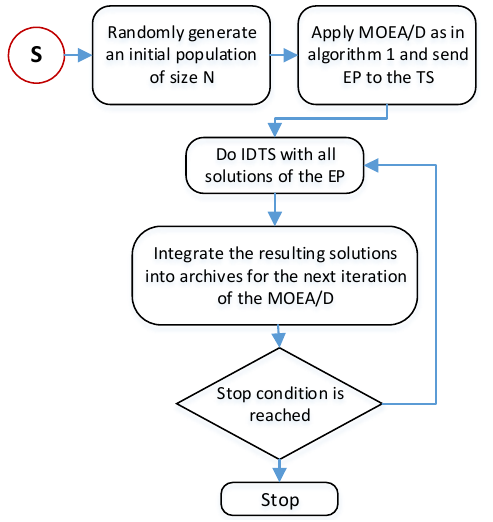
Figure 2. Flow chart of proposed algorithm (MOEA/D-